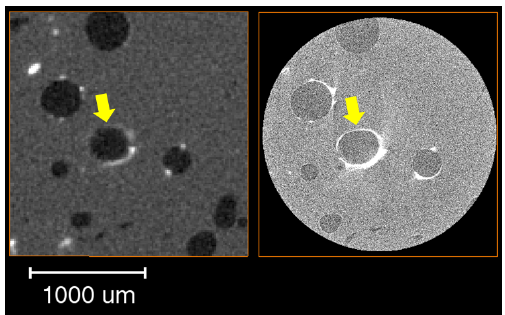
Figure 4. Side-by-side microCT cross sections of the same sam- ple (1.0mM CsCl, frozen in laboratory freezer) imaged at approx- imately 16µm (a) and 2µm (b) voxel sizes. Lighter tones indicate areas of higher radiodensity, i.e., higher solute amounts. The scale bar applies to both images.